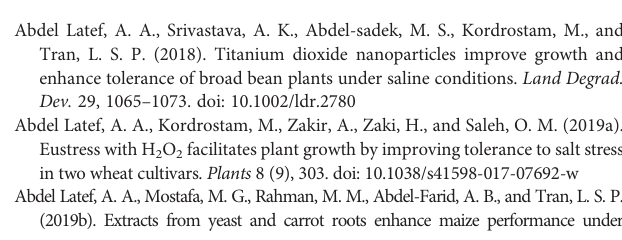
SUPPLEMENTARY FIGURE S1 | Oxygen application method for hydroponic. SUPPLEMENTARY FIGURE S2 | Infrared image to measure canopy